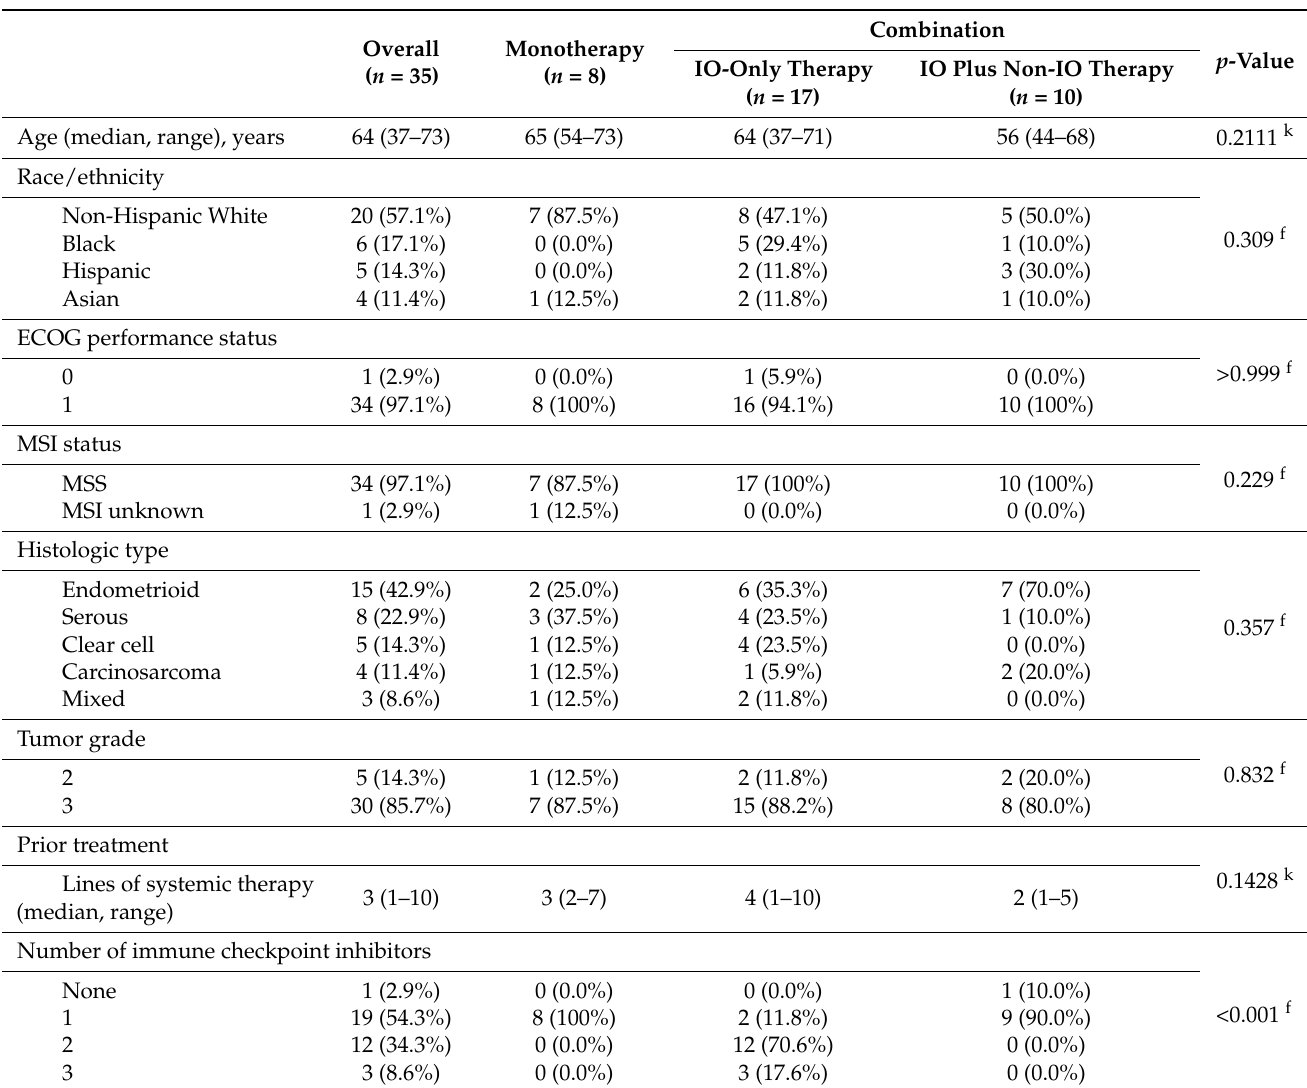
Table 1. Clinical characteristics and treatment regimens for patients with MSS endometrial cancer ( n =